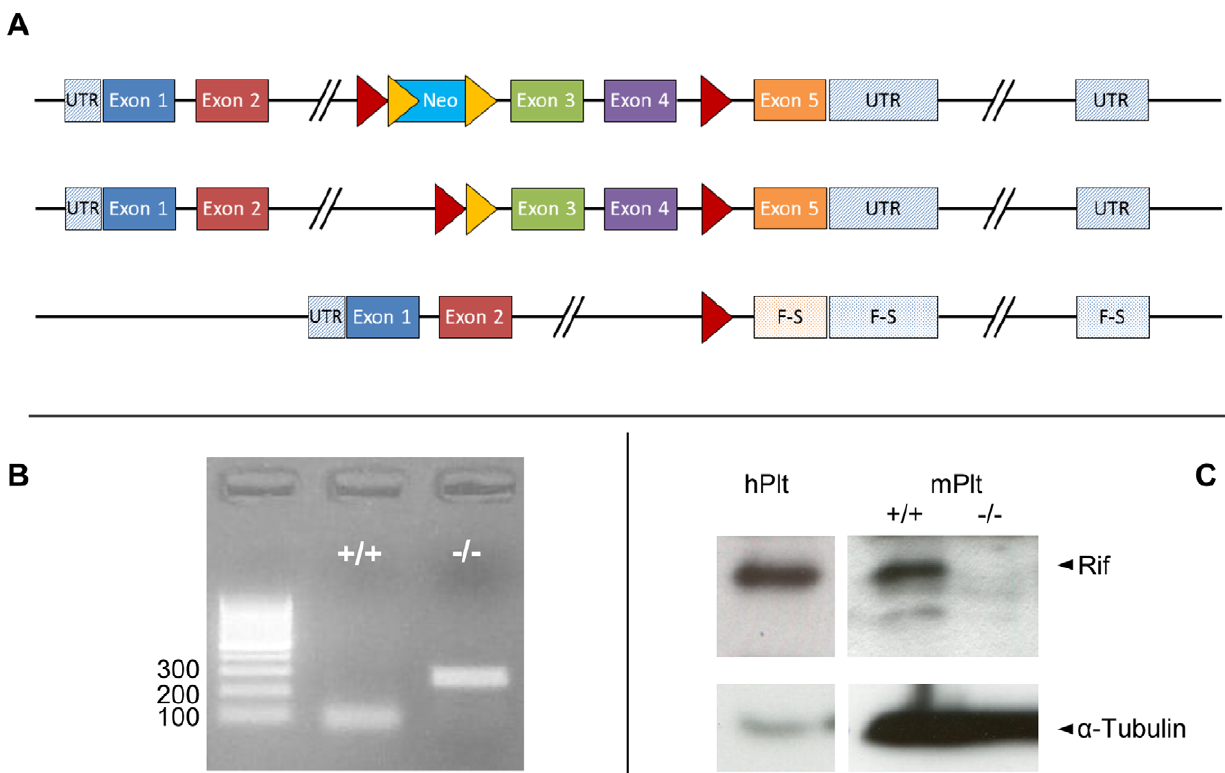
Figure 1. Rif is expressed in human and mouse platelets and is ablated in platelets from a constitutive RhoF 2 / 2 mouse. ( A ) Generation of the RhoF 2 / 2 mouse employed a targeting strategy which permitted generation of conditional or constitutive knockout (KO) mice. Exons 3 and 4 of the RhoF gene were flanked by LoxP sites and a Neo selection marker was inserted flanked by Frt sites such that deletion of exons 3 and 4 caused a frameshift mutation resulting in loss of function. Initially a conditional ready KO was generated after in vivo Flp-mediated removal of the selection marker. A constitutive KO was then generated after Cre-mediated deletion of exons 3 and 4. Red triangles represent LoxP sites, yellow triangles represent Frt sites. Abbreviations: untranslated region (UTR), frameshift (F-S). ( B ) The RhoF 2 / 2 mice genotyping strategy employed a three-primer duplex PCR reaction which generated a wild-type ( + / + ) product 100 bp long and a RhoF 2 / 2 product 250 bp long and enabled identification of both wild-type and RhoF 2 / 2 mice. ( C ) Analysis of Rif expression in human platelets (hPlt) and in wild-type ( RhoF + / + ) and Rif null ( RhoF 2 / 2 ) mouse platelets (mPlt) by Western blot demonstrating expression in human and wild-type mouse platelets and ablation of Rif protein expression in platelets from RhoF 2 / 2 mice.